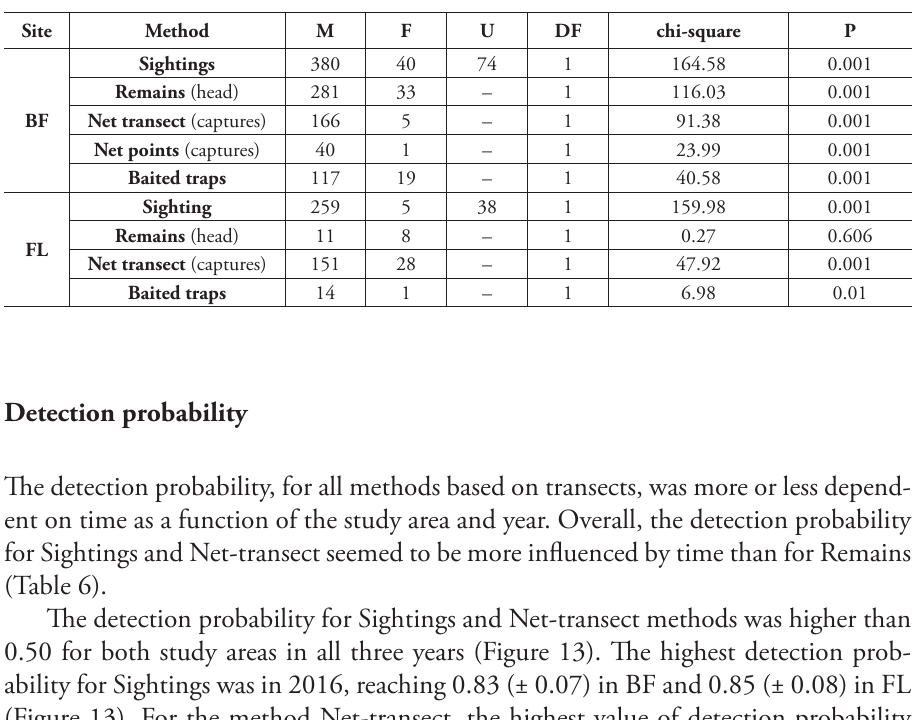
Table 4. Number of males (M), females (F) and unidentified (U) individuals contacted with different methods at Bosco della Fontana (BF) and Foresta della Lama